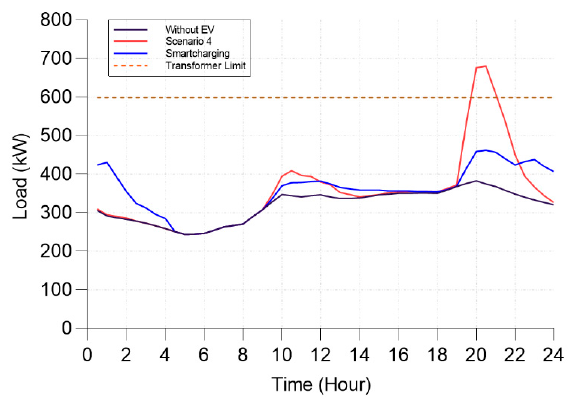
Figure 11. Load profiles, including with smart charging.